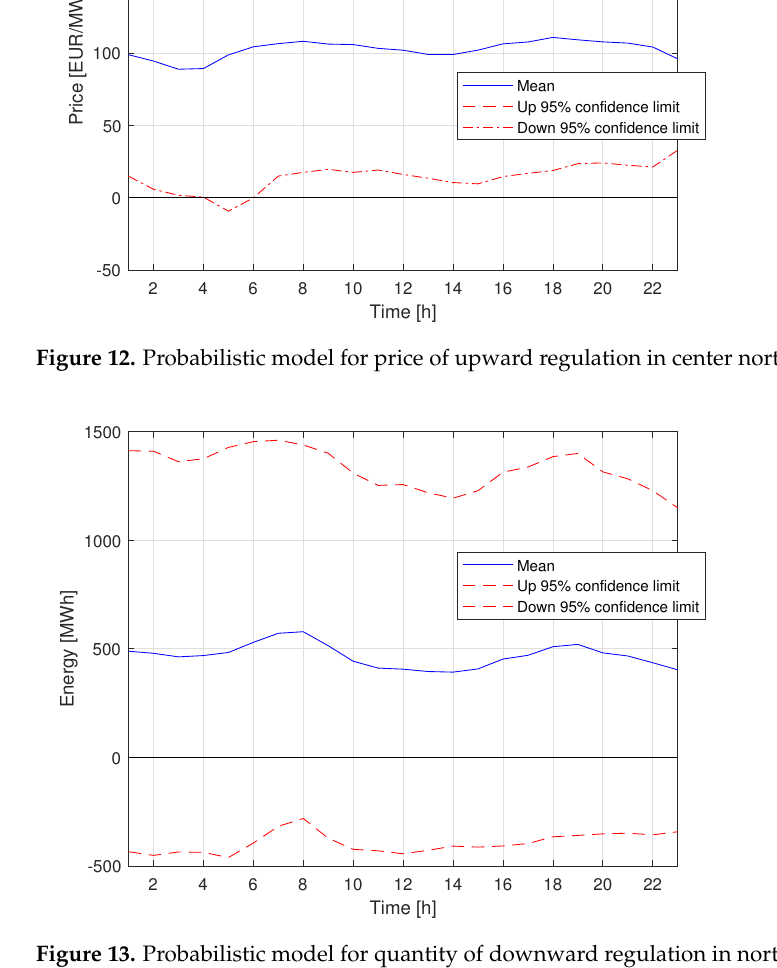
Figure 13. Probabilistic model for quantity of downward regulation in north